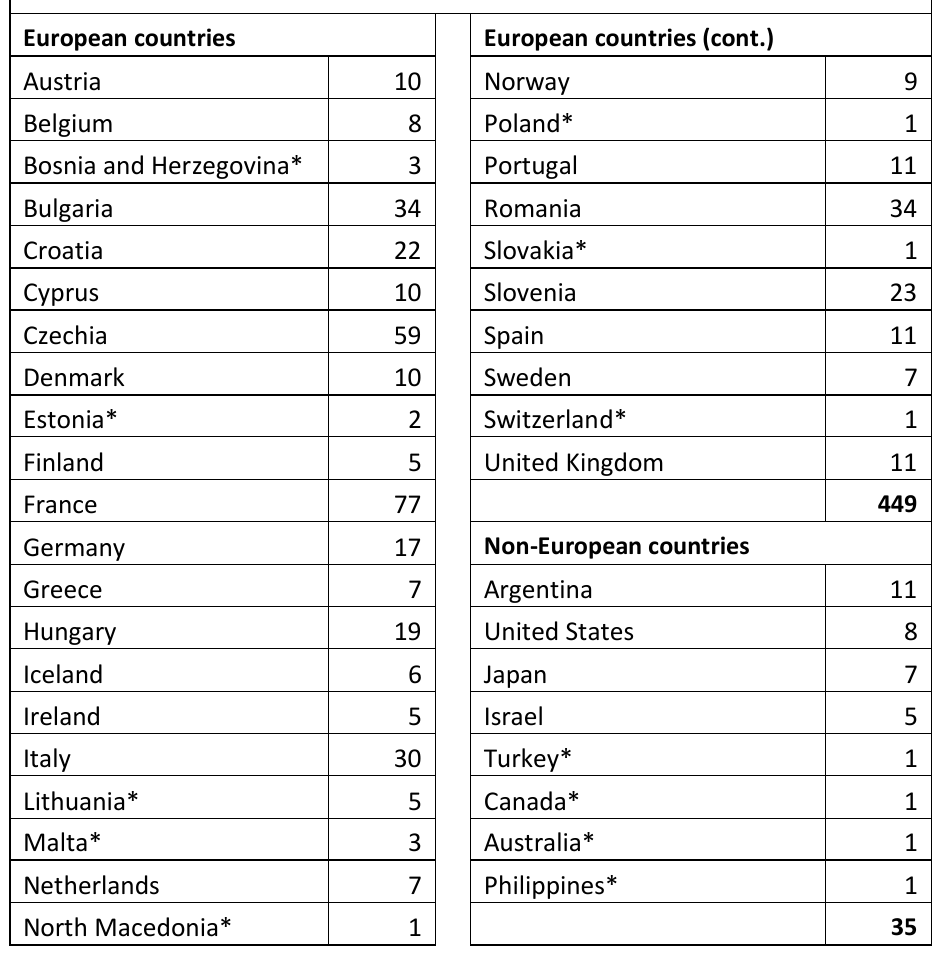
Table 1 : Survey respondents per country (N = 484, all respondents) European countries European countries